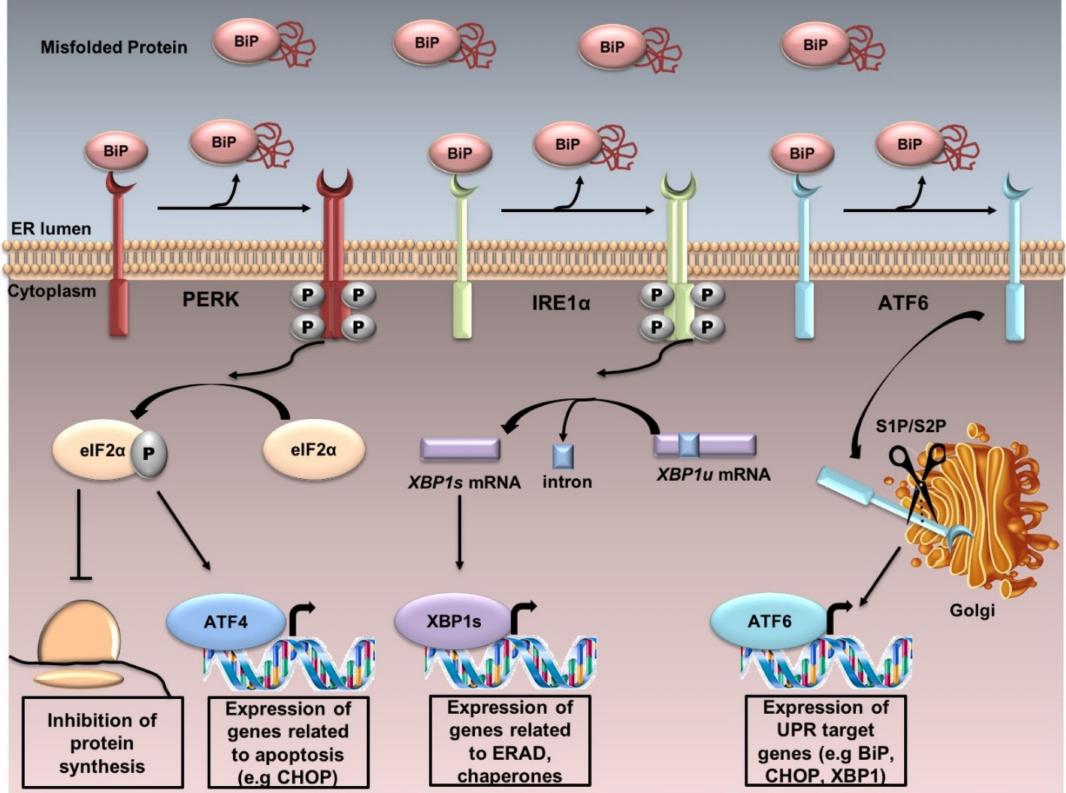
Figure 1. The UPR. UPR is controlled by three sensor proteins: PERK, IRE1 α and ATF6. Under normal conditions, these proteins are associated with BiP and thus remain inactive. Under ER stress, BiP is released from these sensor proteins, and UPR cascade is activated after further dimerization and autophosphorylation of PERK and IRE1 α , and regulated intramembrane proteolysis of ATF6. PERK activation induces the phosphorylation of eIF2 α . Phosphorylated eIF2 α reduces the global protein synthesis and promotes the translation of the activating transcription factor 4 (ATF4) which upregulates the genes related to apoptosis. IRE1 α dimerizes, autotransphosphorylates, and its endoribonuclease activity enables the splicing of the unspliced X-box binding protein 1 XBP1u to the spliced XBP1s. XBP1s upregulates the transcription of several genes involved in UPR and ERAD. ATF6 is localized at the ER in unstressed cells. Under ER stress, ATF6 translocates from the ER to the Golgi, where it is cleaved sequentially by the enzymes site 1 protease (S1P) and site 2 protease (S2P). Active ATF6 is transferred into the nucleus, where it binds the promoters of several genes involved in UPR (such as C / EBP α -homologous protein (GADD153 or CHOP), BiP, XBP1). PERK is a type I ER transmembrane protein, containing a cytoplasmic serine / threonine protein kinase domain. PERK activation induces the phosphorylation of the α subunit of eukaryotic translation initiation factor (eIF2 α ) at the residue serine 51. Phosphorylated eIF2 α (p-eIF2 α ) reduces the global protein synthesis and promotes the translation of ATF4 because of a longer resident time on its first uORF (upstream open reading frame) of the translation initiation complex. ATF4 upregulates the genes related to apoptosis, including the pro-apoptotic factor GADD153 or CHOP. The PERK / ATF4 /